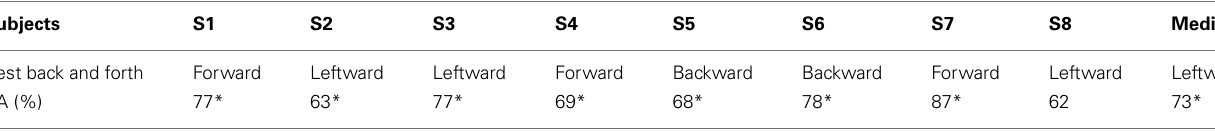
The best endpoint inference from the MER2a component was obtained for single center-out vs. center-in (“Best back and forth”) movements, see Figure 8C ; *Significant at P < 0.01.